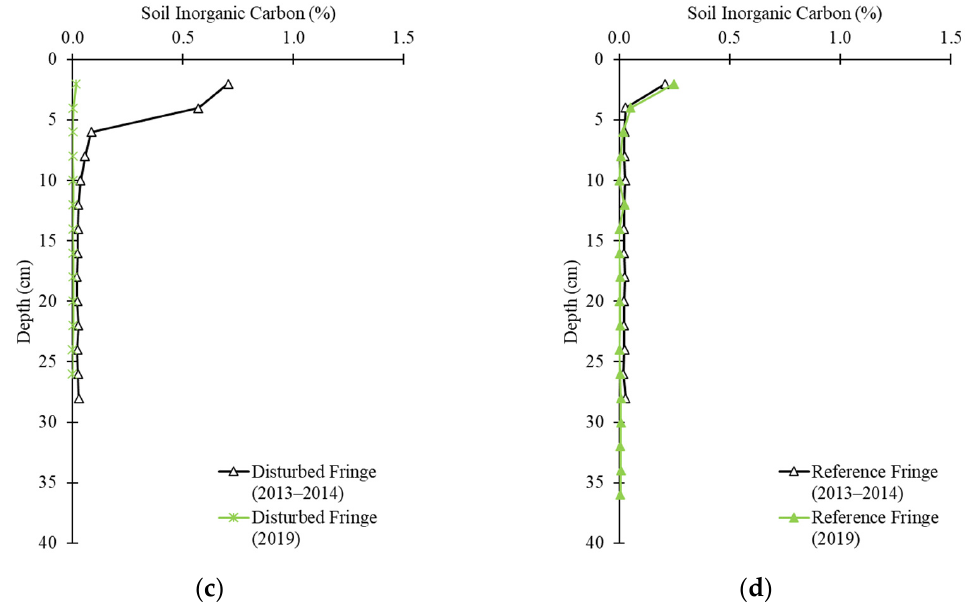
Figure 5. Soil inorganic carbon concentration in the period 2013–2014 and 2019 at each 2 cm of depth in ( a ) the disturbed riverine site; ( b ) the reference riverine site; ( c ) the disturbed fringe site; and ( d ) the reference fringe site.